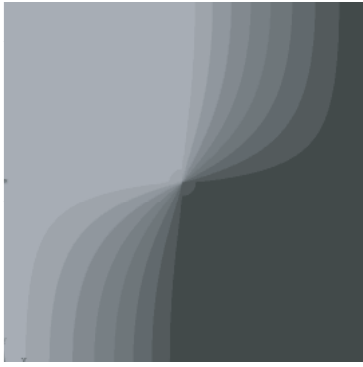
Figure 3.2. Distribution on V of the function v ( x ) = u ( x )+ x 1 , where u is the (FEM) solution ( v = − 1 on the left boundary and v = 1 on the right